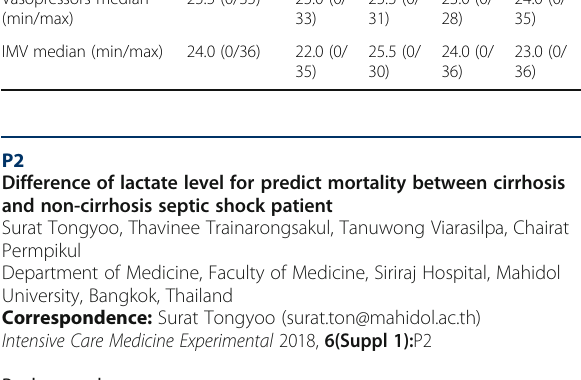
Table 2 (abstract P1). Vasopressors and ventilator free days Days alive and free